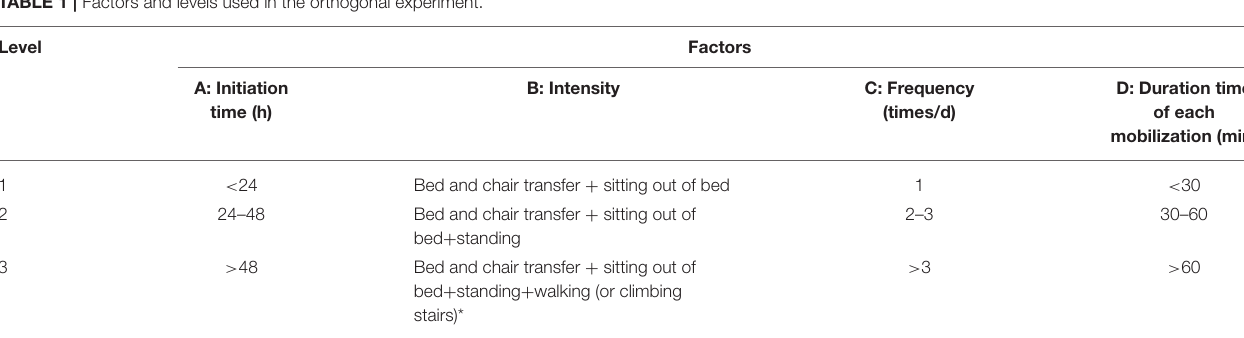
TABLE 1 | Factors and levels used in the orthogonal experiment.